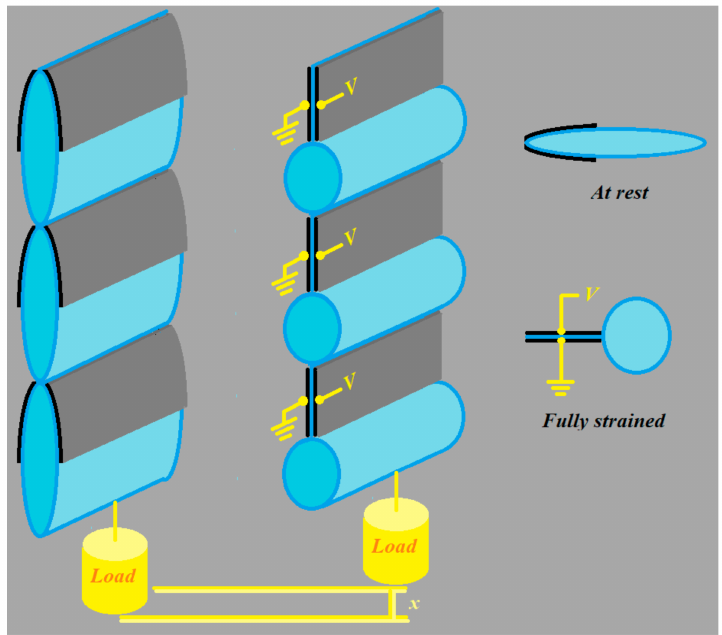
Figure 2. (Above) The design for the peano HASEL actuator with the zip mechanism